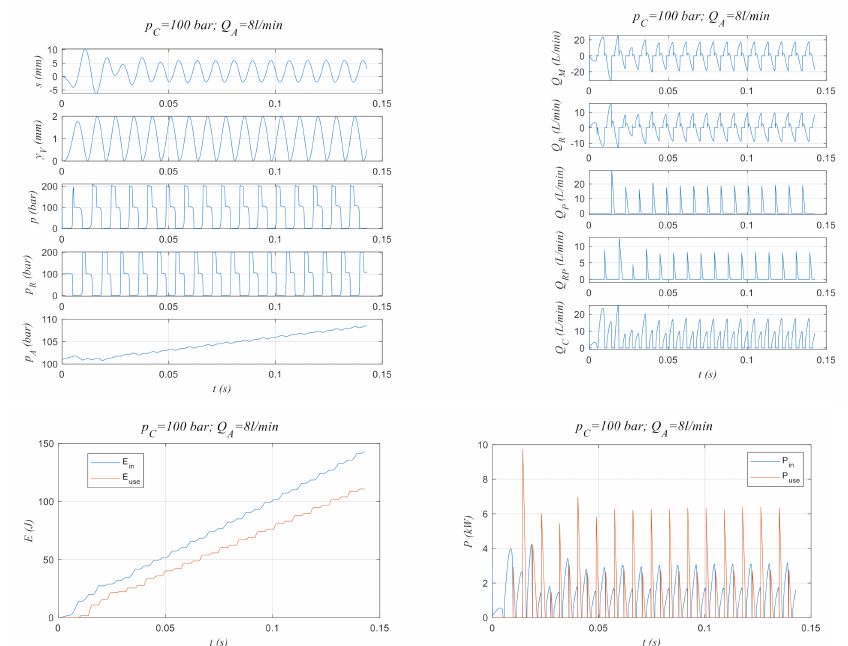
Figure 9. Results plots for p C = 100 bar, Q A = 8 L/min; s: piston position; y V : position valve spool; p,